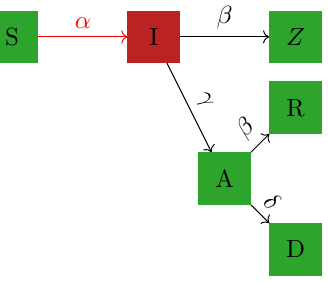
Figure 1. Schematic of the local epidemiological compartmental model which describes the state of the country at any given time. The population of each country is divided into six mutually exclusive compartments: susceptible ( S ), undetected infected ( I ), active confirmed ( A ), confirmed recovered ( R ), confirmed deceased ( D ), and unconfirmed removed ( Z ). The basic reproductive number in this model is given by R 0 = α/(γ + β)